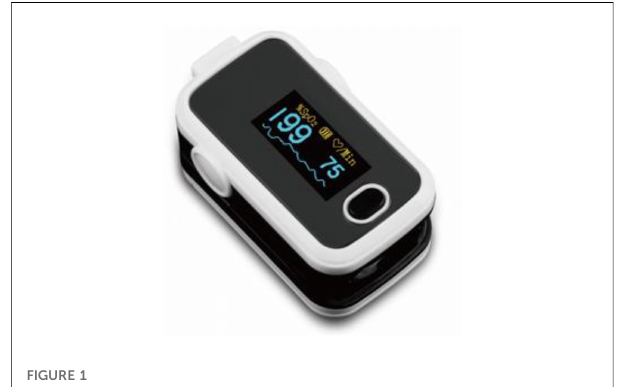
FIGURE 1 Ihealth pulse